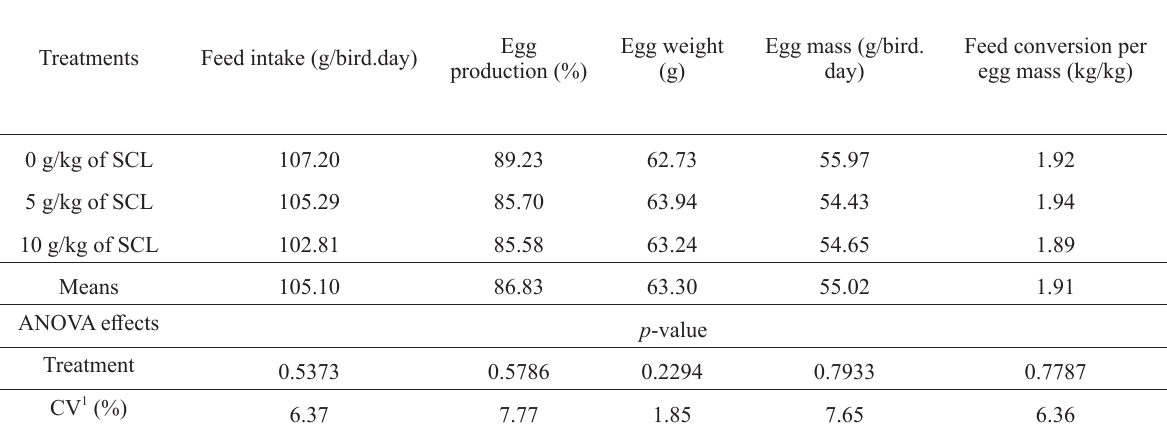
Performance of laying hens fed diet with different levels of Syzygium cumini leaves (SCL).